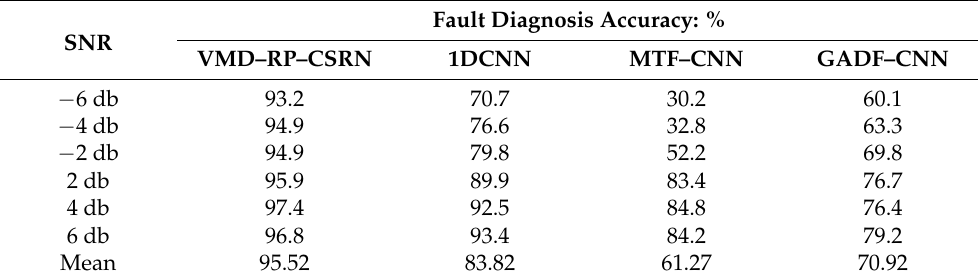
Table 2. Experimental results of the VMD–RP–CSRN model for noise.